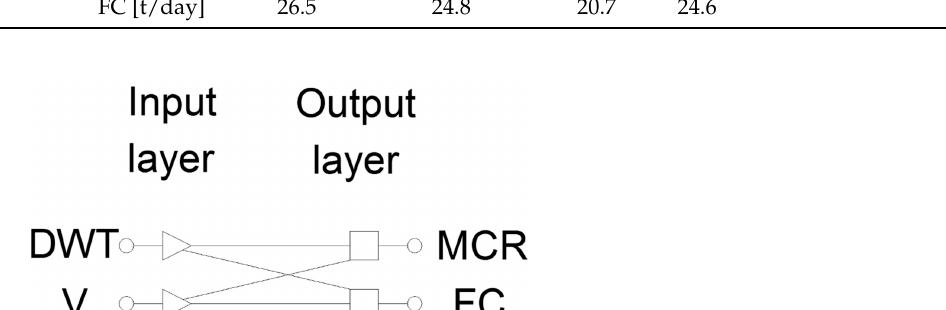
Figure 4. The structure of the artificial neural networks to estimate the engine power (MCR) and fuel consumption (FC) of bulk carriers and tankers, where DWT—deadweight and V—speed.